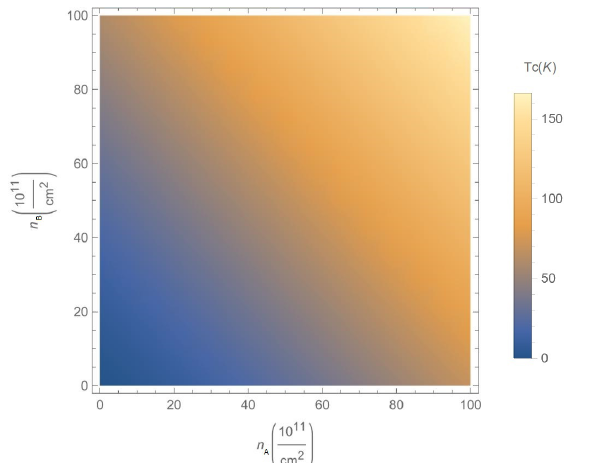
Figure 14. Density plot for the mean-field phase transition critical temperature T c ( n A , n B , α , ∆ , D ) versus the concentrations n A and n B of A and B excitons, respectively, for chosen parameter α = 0.6 and gap ∆ = 0.5 ¯ hv F / a , at the fixed interlayer separation D = 25